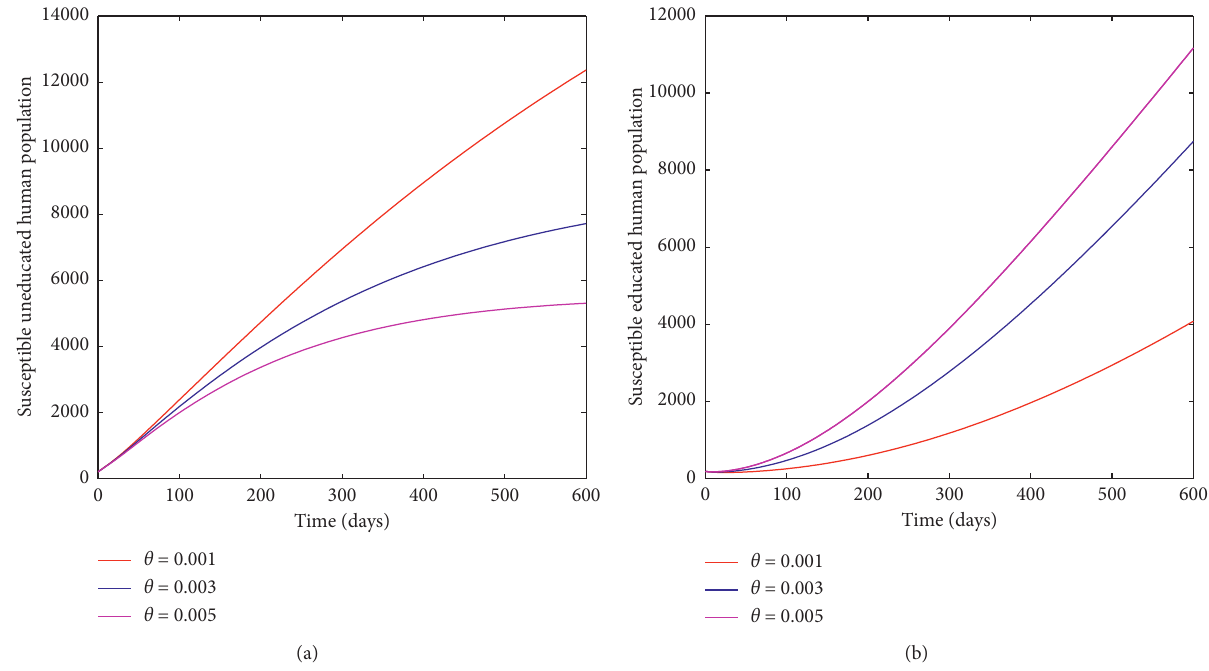
Figure 8: Variation in public health education rate on susceptible human